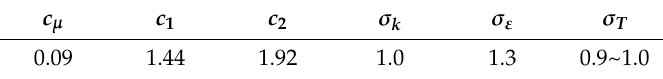
Table 1. Coe ffi cient of standard k- ε model.